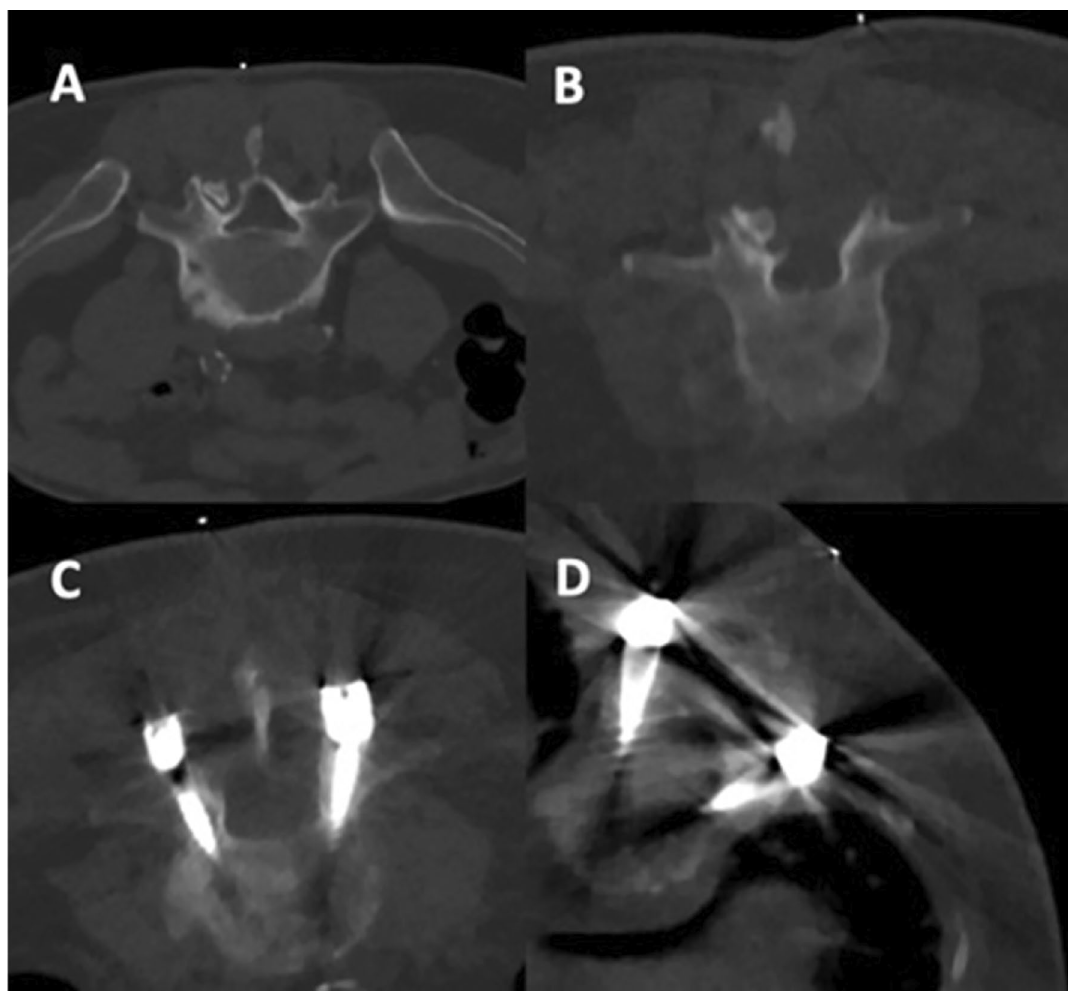
Figure 2. Examples for planning scans for lumbosacral spine biopsies in different patients performed with a low-dose (LD) protocol for scanning, which were rated with perfect ( A ), good ( B ), medium ( C ), and poor ( D ) overall image